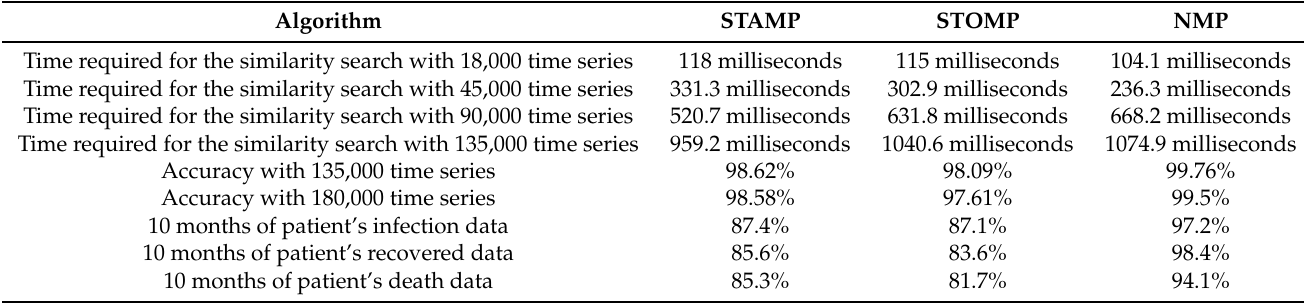
Table 2. The performance of the proposed and compared